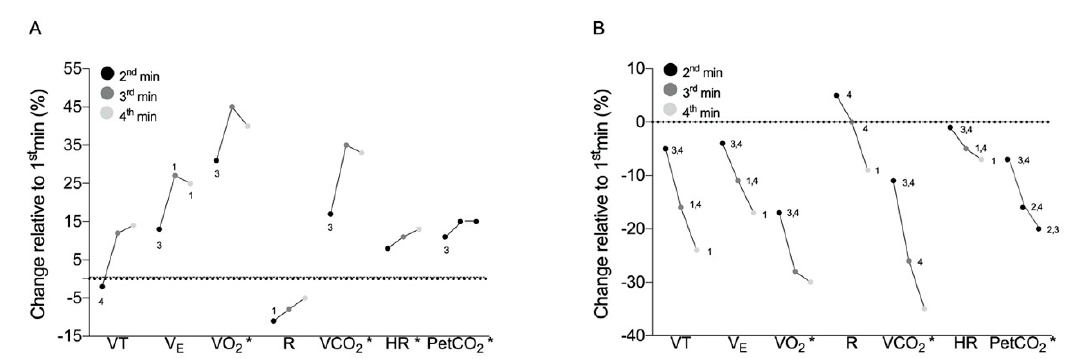
Figure 2. Percentage of change of the cardiopulmonary variables in the 2nd, 3rd and 4th min relative to the 1st min in CPR ( A ) and CPR-Run ( B ) conditions (the horizontal dashed line represents the 1st-min mean value). 1,2,3,4 Different from the 1st, 2nd, 3rd and 4th min, respectively; * 1st-min different from all min ( p < 0.05).